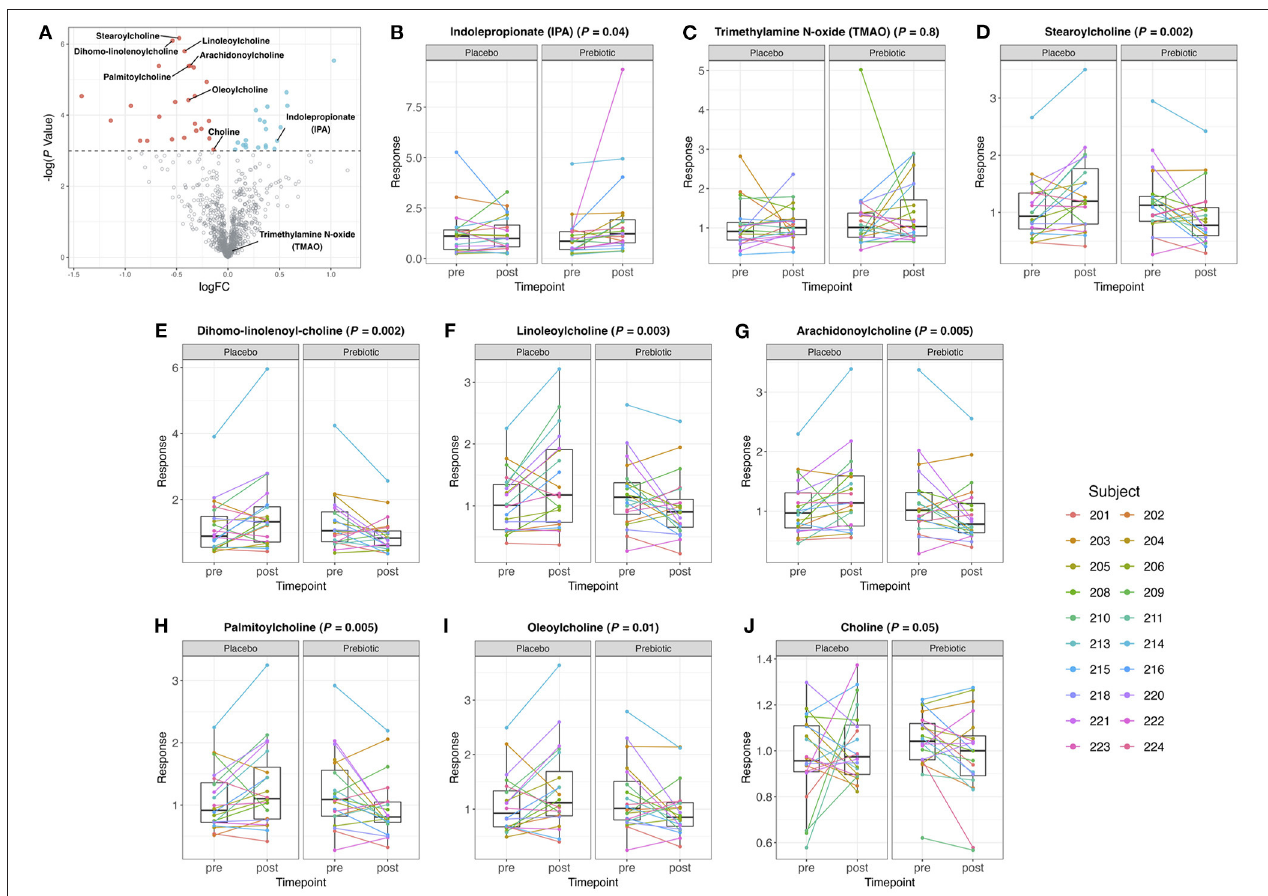
FIGURE 4 | (A) Volcano plot of all metabolites in human plasma samples. Metabolites with a logFC > 0 and a –log( P -value) > 0.05 are colored blue and metabolites with a logFC < 0 and a –log( P -value) > 0.05 are colored red. All the other metabolites are colored gray. (B–J) Box plots of IPA, TMAO, choline, and acylcholines concentrations pre- and post-treatment with placebo or prebiotic (unadjusted P -value).